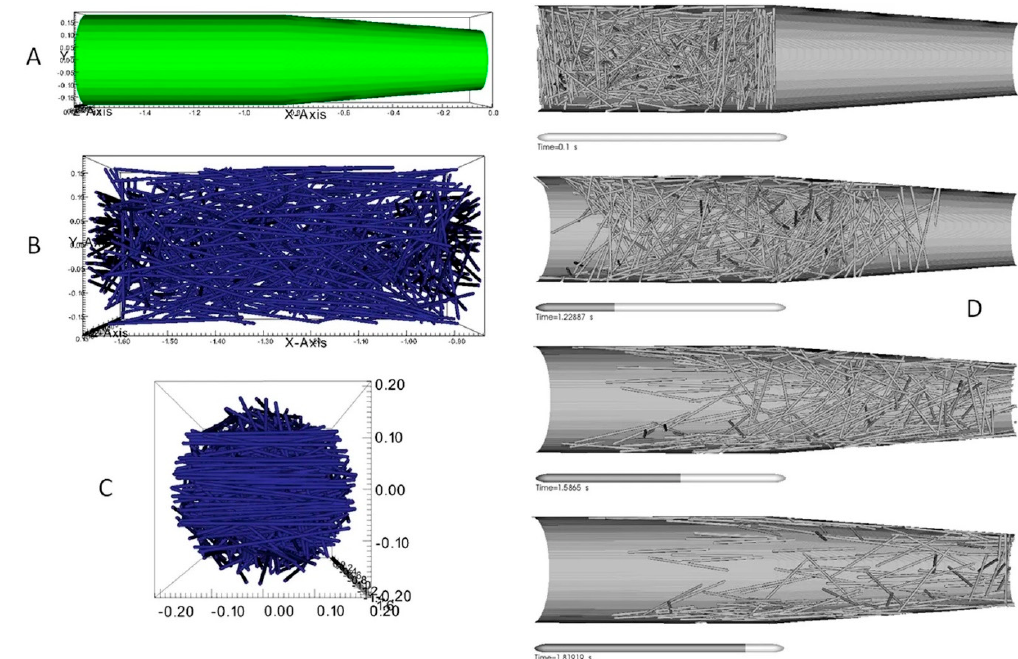
Figure 5. High resolution numerical simulation of a carbon fiber loaded ink under conditions of microextrusion during a direct ink writing (DIW) printing process to form an additively manufactured carbon-fiber-reinforced composite (AMCFRC). ( A ) represents the total computational domain for these simulations which cylindrical/conical volume, terminating in a 400- μ m orifice and is representative of the last 2 mm of the actual extrusion head. ( B , C ) are the side and end views showing the initial (random) fiber partial distributions within the contiguous phase. ( D ) represents the time-resolved evolution of the fiber orientations in 3D within the computational domain under the simulated conditions of printing. Note that the simulation predicts what appears to be a wall dominated shear alignment process that follows closely the predicted velocity profile of the fluid. Reprinted from [23], © 2017, with permission from Springer